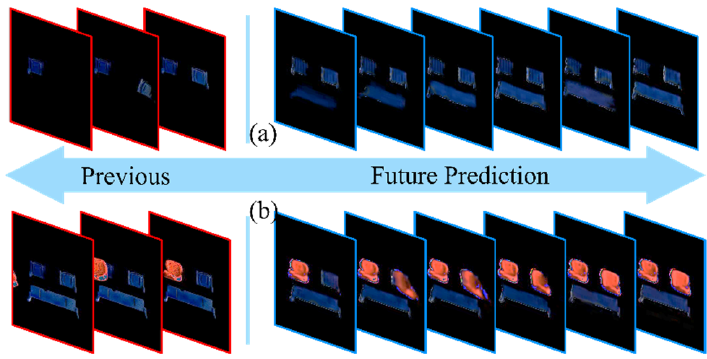
Figure 7. Prediction of the back seat holder installation ( a ), and the right seat installation ( b ). It can be seen that the first predicted actions are the back seat holder being installed after the right seat holder assembly in the long-term prediction, as shown in Figure